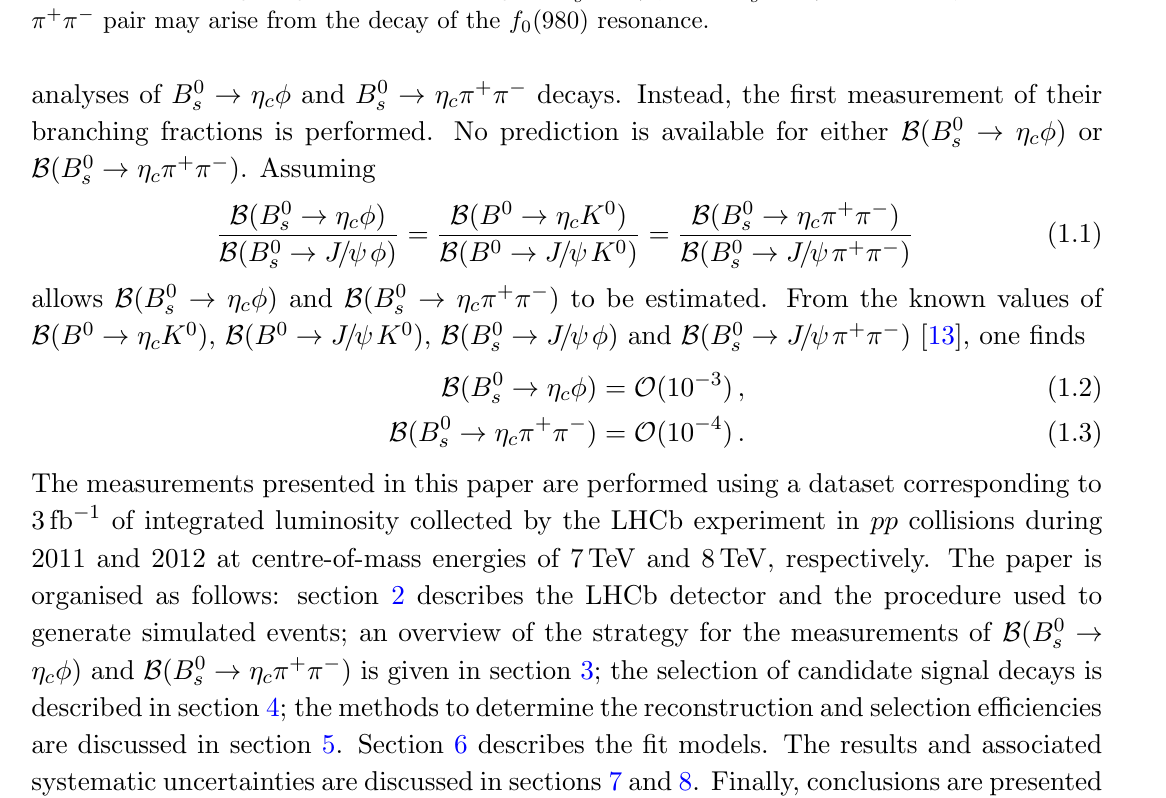
! (cid:17) c (cid:30) and B 0 ! (cid:17) c (cid:25) + (cid:25) (cid:0) decays, where the s s